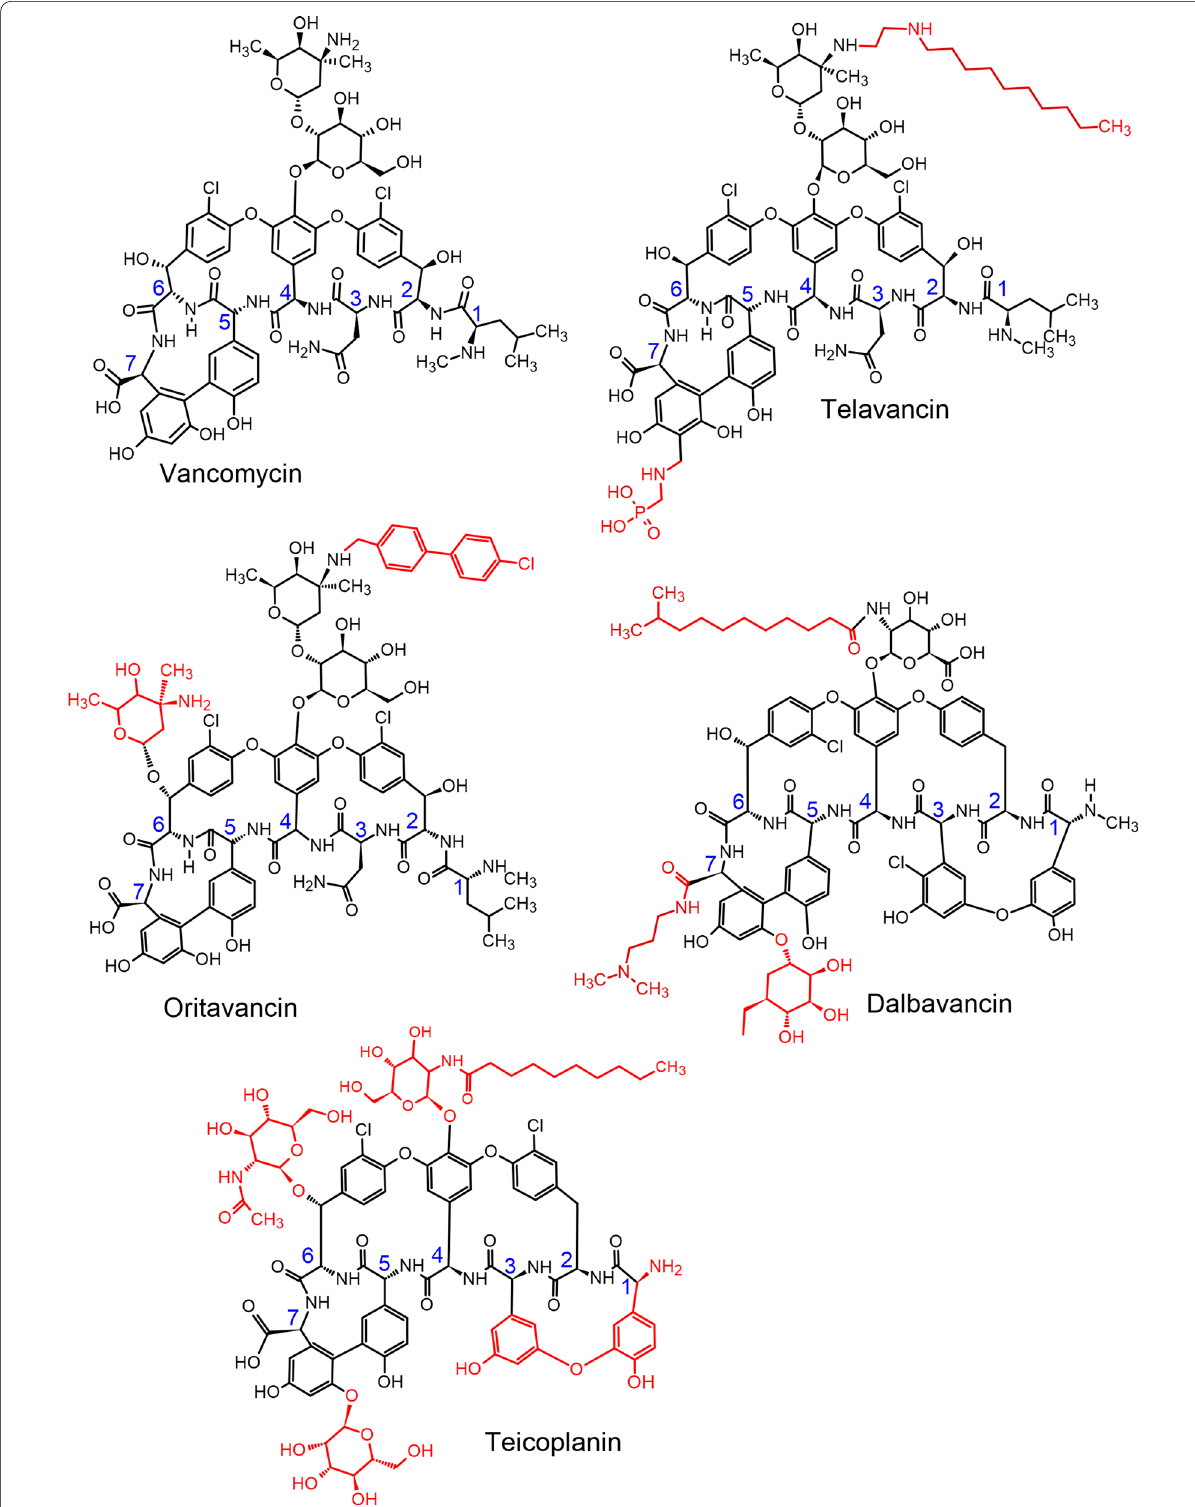
Fig. 1 Structures of glycopeptide and lipoglycopeptide antibacterial drugs included in this review. The shared cyclopeptide frame of the drugs is shown in black, with the α-carbons of the residues numbered in blue. Key structural modifications of the basic vancomycin structure are highlighted in red